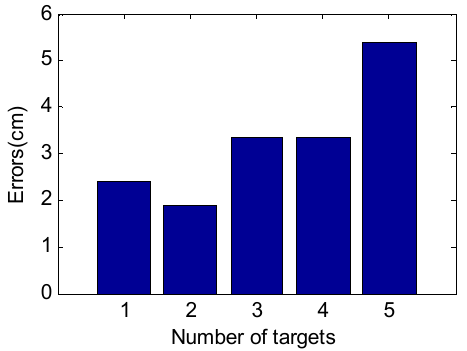
Figure 10. The median errors of different number of targets.